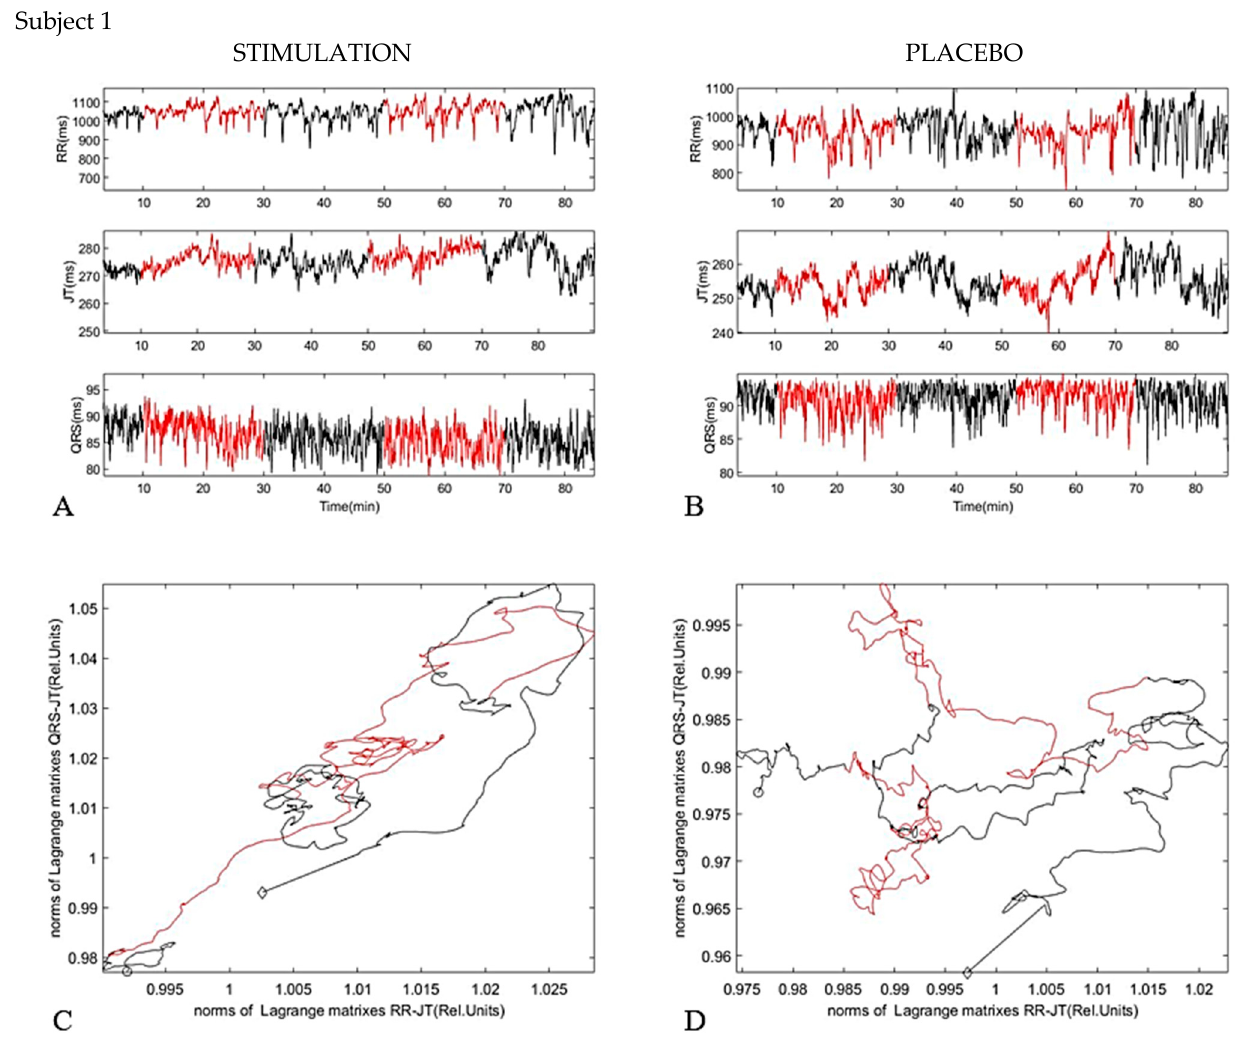
Figure 5. Subject 1. ( A ) dynamic of parameters RR interval, JT interval, and QRS duration during investigation (Stimulation). ( B ) dynamic of parameters RR interval, JT interval, and QRS duration during investigation (Placebo). ( C ) phase plane for JT/QRS and RR/JT norms during stimulation. ( D ) phase plane for JT/QRS and RR/JT norms during placebo. The beginning of the experiment is marked as a black circle, the end of the experiment marked as a black diamond marker. In total, more than 5000 cardio cycles were recorded and estimated.